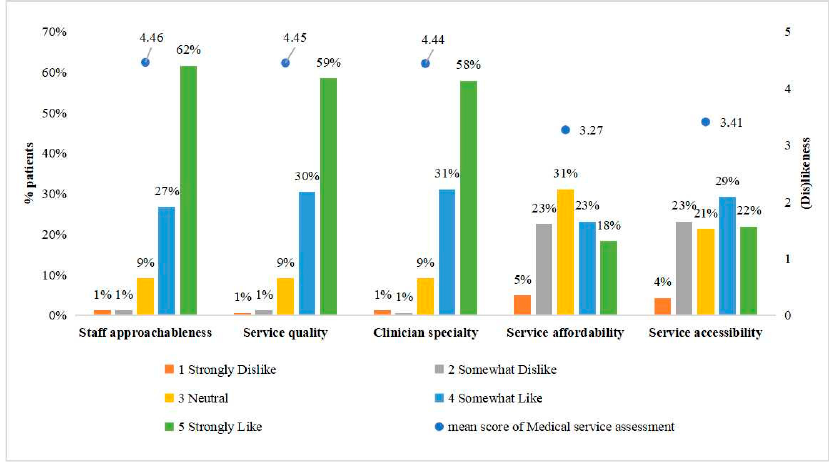
Figure A2. Medical service assessment of sample patients ( n = 164).